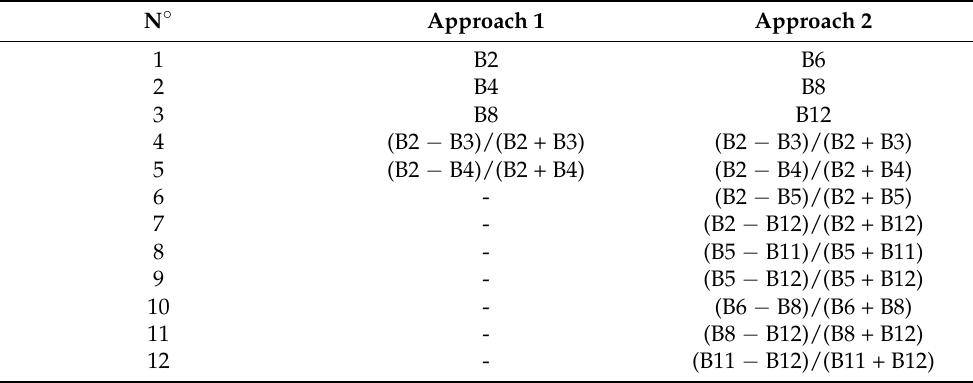
Table 4. Selected predictor variables for training models in approaches 1 and